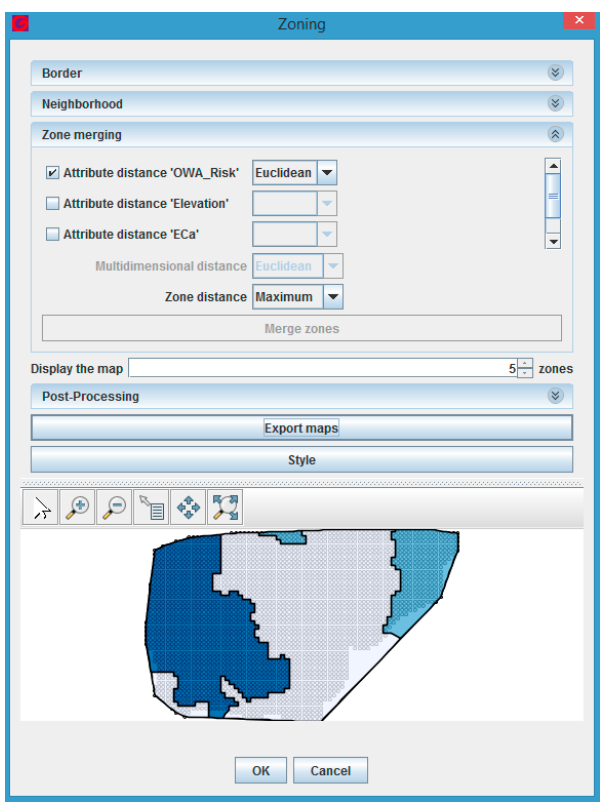
Figure 12. Delimitation of within-field yield zones of the risk of having sub-optimal management practices. (Map details described in Figure 13).